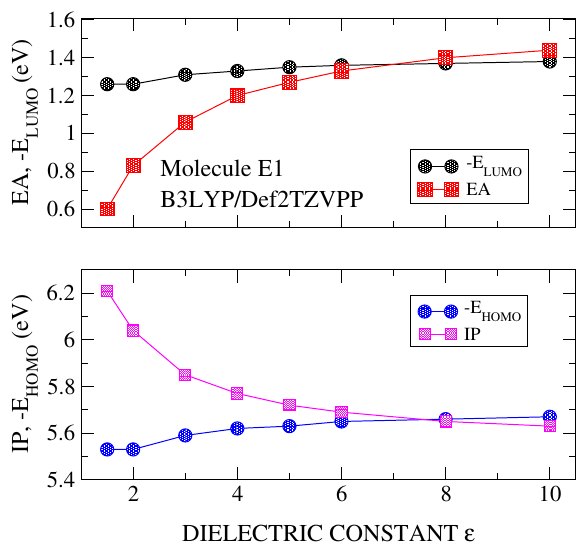
Figure 2. Calculated values of ionization potential (IP) and E HOMO ( lower panel ) and electron affinity (EA) and E LUMO ( upper panel ) for molecule E1. Calculations were carried out with B3LYP/Def2TZVPP method and using polarizable continuum medium (PCM) with a dielectric constant ε varying in the range 1–10.